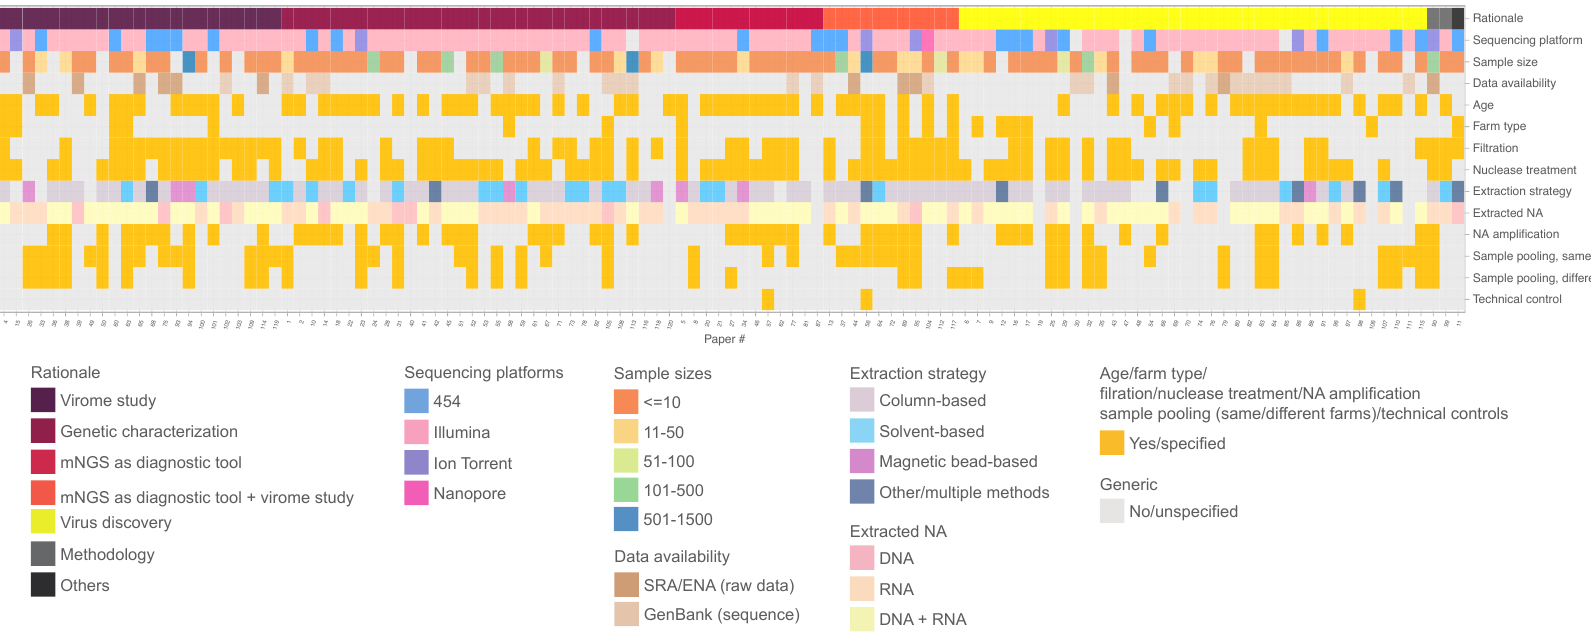
Figure 2. An overview of study design and data (and metadata) availability of 120 included publications. Each column represents one paper, and numbers refer to the list of references (Supplementary Materials). Rows describe data fields extracted from the papers as follows (from top to bottom): study rationale, sequencing platforms, sample sizes, availability of sequencing data in public repository, availability of animal age description, availability of farm type description, indication of whether filtration was performed, indication of whether nuclease treatment was performed during sample preparation, nucleic acid extraction strategy, type of nucleic acid extracted, indication of whether nucleic acid amplification was performed, indication of whether sample pooling was performed in same / di ff erent farms, and mention of technical controls for validating sequencing results. Categories and color codes for each data field are indicated in the figure legend. Gray boxes indicate that the technique was not performed, or the information was not specified. mNGS = metagenomic Next-Generation Sequencing. SRA = Sequence Read Archive. ENA = European Nucleotide Archive. NA = nucleic